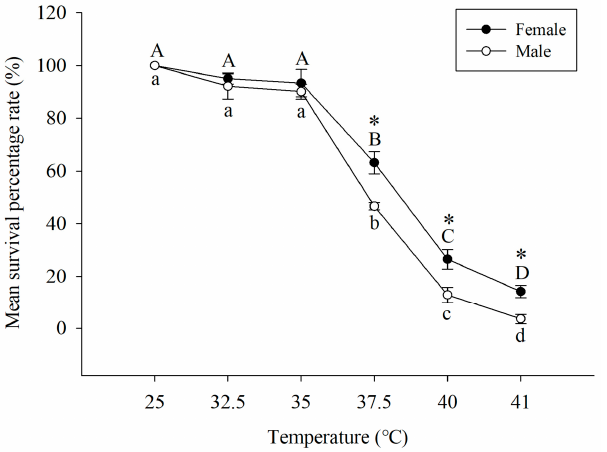
Figure 1. The average survival rate of Aphelinus asychis . Uppercase and lowercase letters indicate significant differences between adult females and males treated at different temperatures ( p < 0.05). Asterisk (*) indicates a significant difference between adult males and females in each temperature treatment ( p < 0.05).